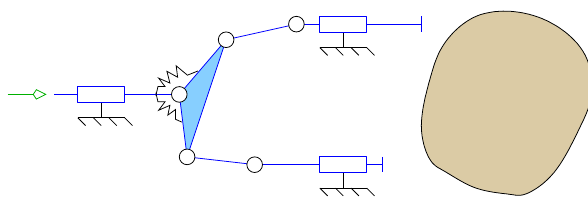
Figure 9. A self-adaptive gripper based on architecture C234 .